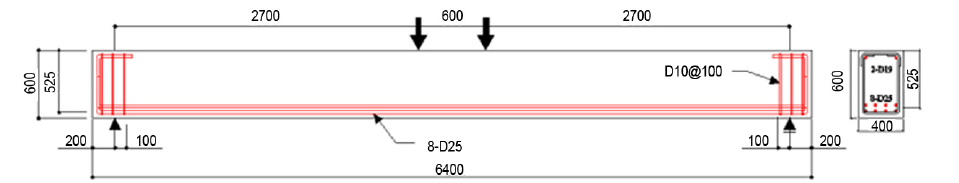
Fig. 1. Section dimensions (a/d = 5.0, unit: